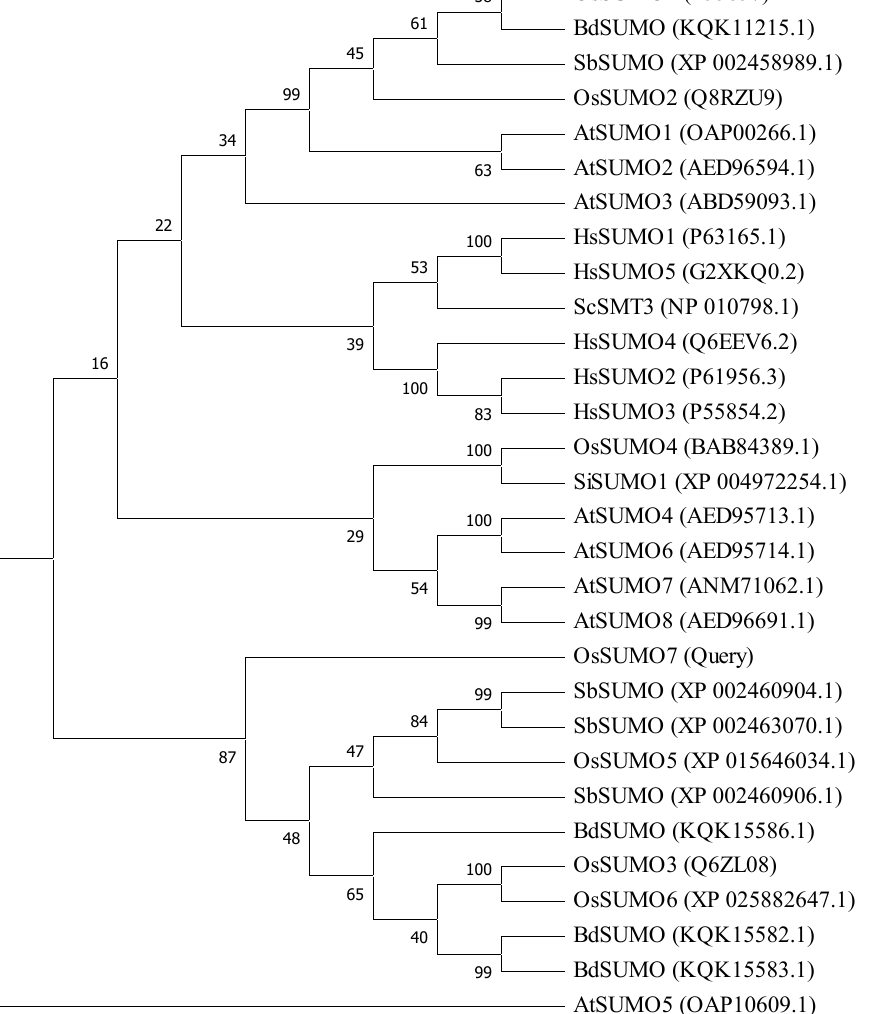
Figure 3. Phylogenetic tree analysis of SUMO genes. Multiple sequence alignment result of SUMOs from ClustalW. Os refers to Oryza sativa , At refers to Arabidopsis thaliana , Hs refers to Homo sapiens , Bd refers to Brachypodium distachyon , Si refers to Setaria italic , Sb refers to Sorghum bicolor , and Sc refers to Saccharomyces cerevisiae .